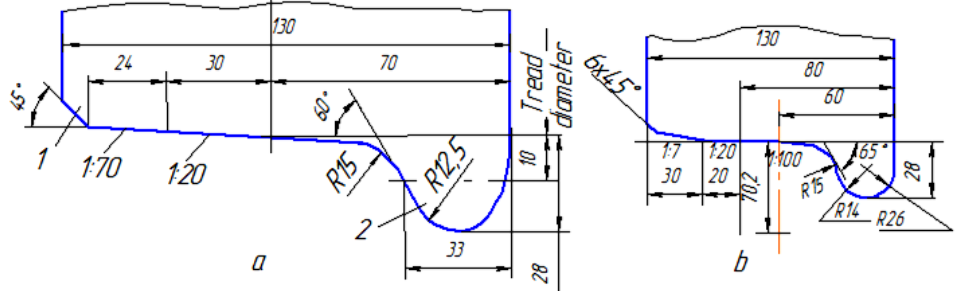
Figure 10. Profile of the wheel tread surface: ( a )—standard; ( b )—according to the Central Research Institute of the Ministry of Railways. Institute of the Ministry of